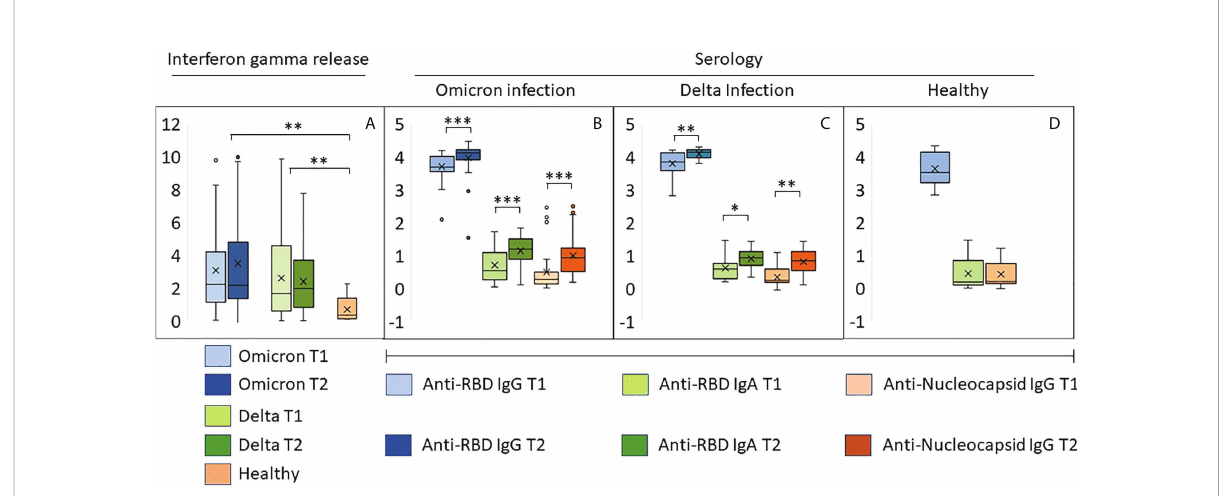
FIGURE 2 Early immune responses in individuals infected with Omicron or Delta. (A) Results from whole blood IFN g release assay (IGRA, IU/ml) in samples harvested from the same individuals with an interval of 8-10 days. T1: inclusion, T2: one week follow up. (B – D) The bar graphs show relative levels (log 10) of antibodies to RBD and the nucleocapsid protein in samples described under (A, B) Individuals with con fi rmed Omicron infection, (C) : Delta infection, (D) : vaccinated individuals with no history of SARS-CoV-2 infection. ***p<10 -5 , **p<10 -3 , *p<10 -2 . Source data are found in Supplemental Table